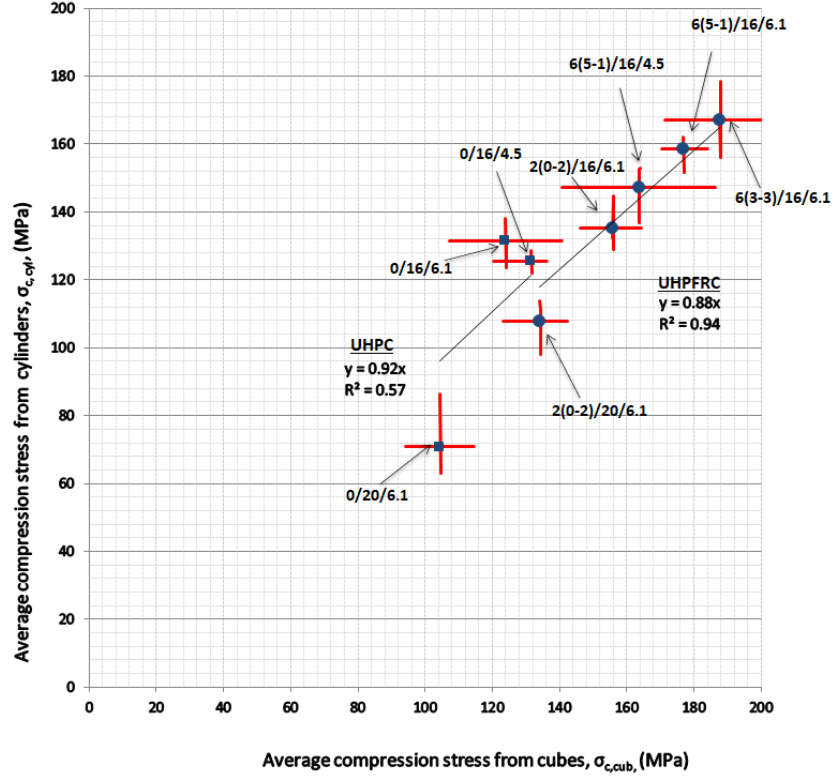
Figure 7. Correlation of compressive strength from cubes and